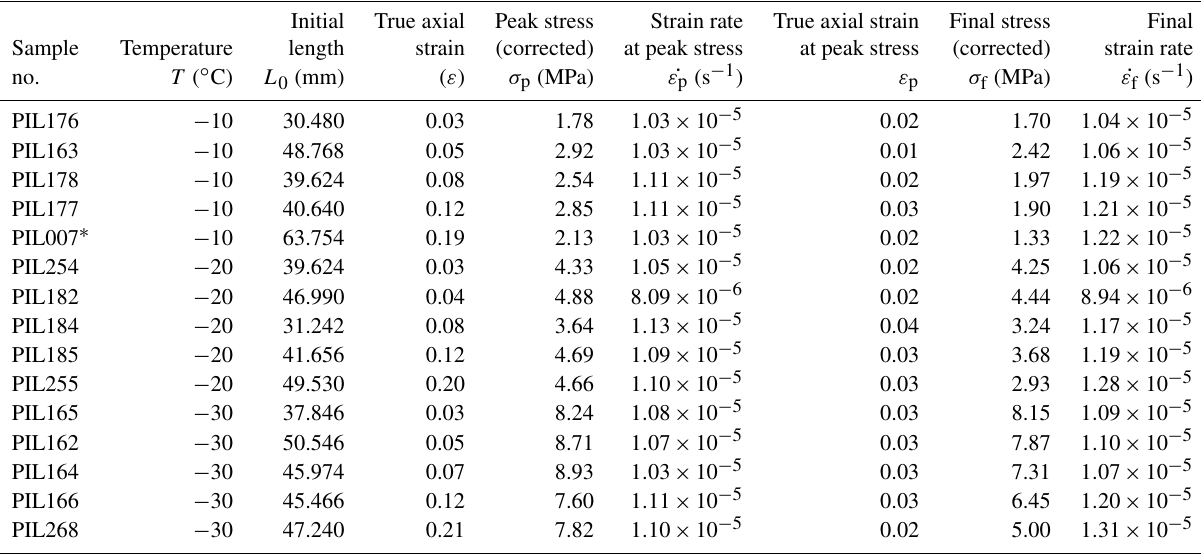
Table 1. Summary of